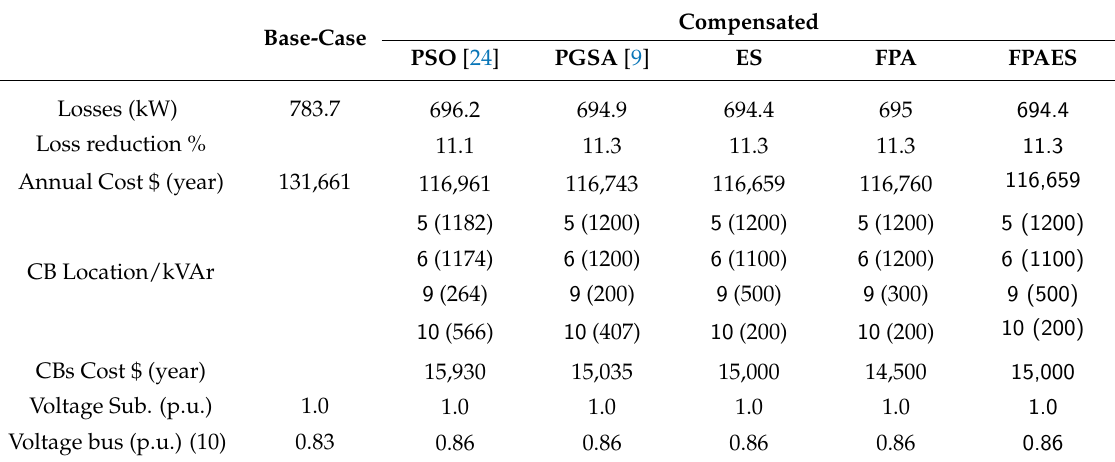
Table 4. Simulation results of the 10-bus system.